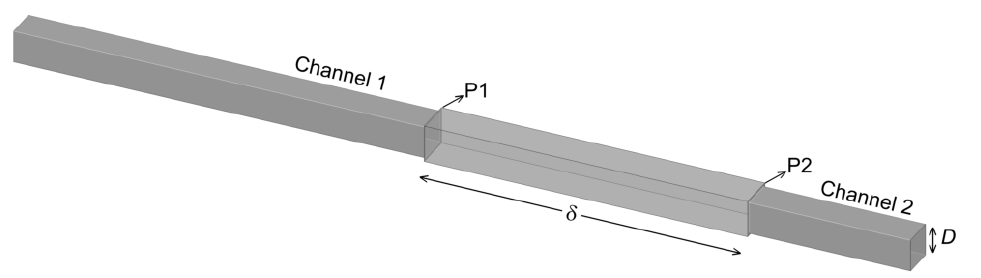
Figure 1. Schematic of the domain. P 1 and P 2 are transverse planes at the outlet of Channel 1 and inlet of Channel 2,